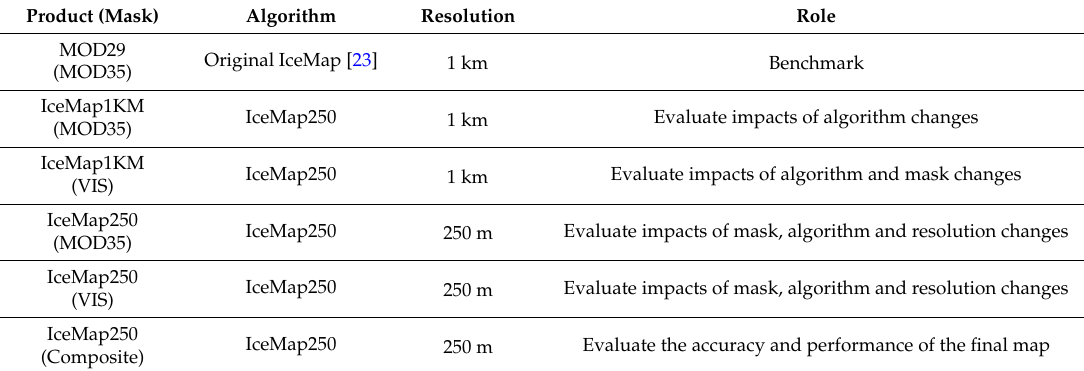
Table 3. IceMap250 validation components and their roles in the validation